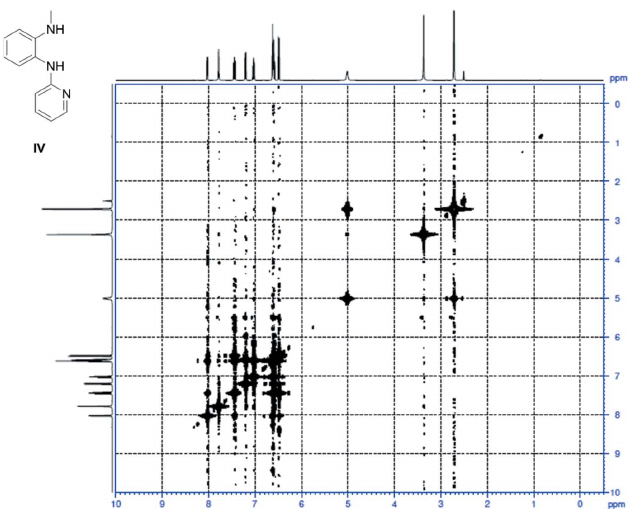
Figure 1 Two-dimensional COSY spectrum of N -methyl- N -phenyl-1,2-diamino- benzene, IV ( d 6 -DMSO).